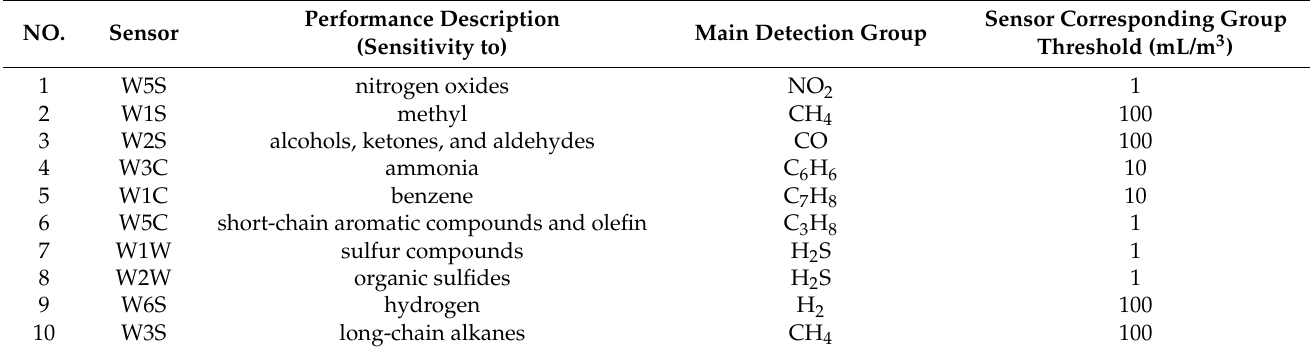
Table 1. Metal oxide conductivity gas sensors of the E-nose [24].